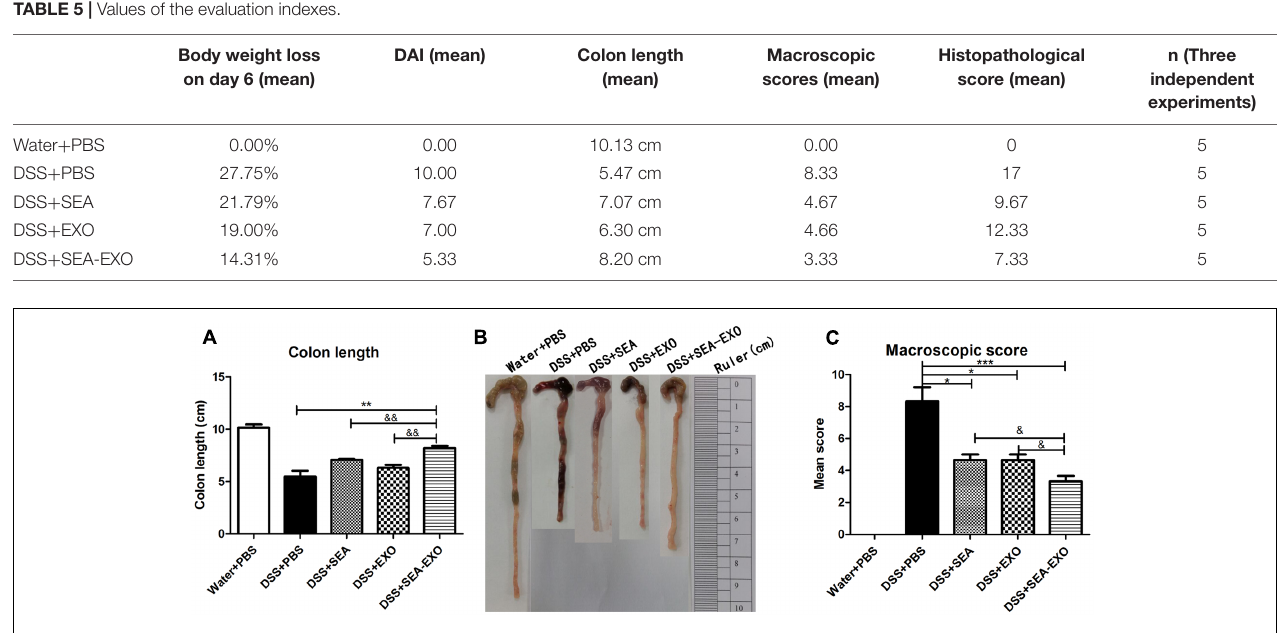
FIGURE 3 | Colon length and colon macroscopic scores in acute DSS-induced colitis mice treated with exosomes. (A) On day 6, the mice were sacrificed, and their colons were removed. Colon length was measured as an indirect marker of inflammation. (B) The macroscopic appearance of colons. Mean colon length and typical injury findings are presented. (C) Mean macroscopic scores of colons. Statistical analyses of multiple groups were performed using a one-way ANOVA followed by Dunnett’s multiple comparison post hoc test versus DSS+PBS ( ∗ P < 0.05, ∗∗ P < 0.01, ∗∗∗ P < 0.001). Statistical significance between two experimental groups was assessed using the Independent-Sample t -test ( & P < 0.05, && P <